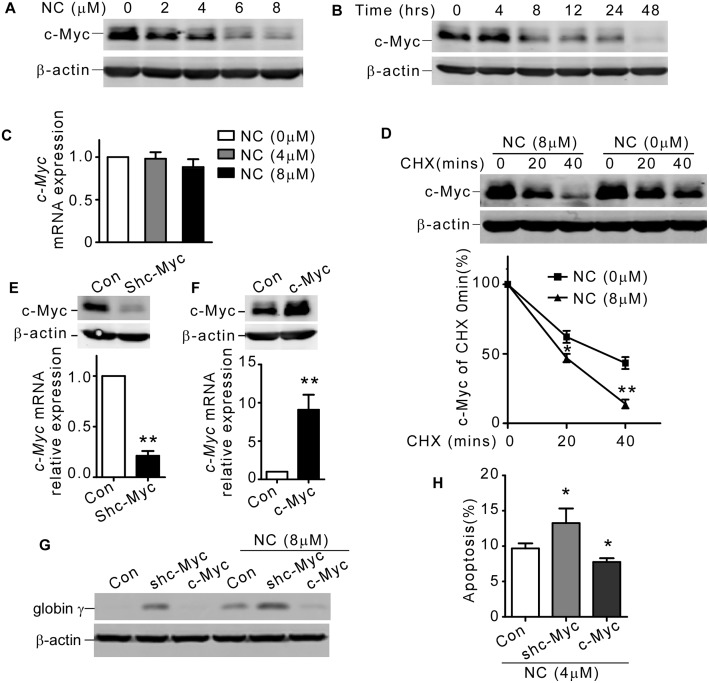
NC downregulated c-Myc protein level by accelerating degradation in K562 cells.(A and B) K562 cells were treated with 0, 2, 4, 6 or 8 μM NC for 2 days, or 8 μM NC for 0, 4, 8, 12, 24 and 48 hrs. Western blot analysis was performed to examine the expression level of c-Myc, and β-actin was used as internal control. (C) Real time qRT-PCR showed the c-Myc mRNA levels in K562 cells treated with indicated concentrations of NC for 2 days. β-actin was used as internal control. The values represent the means ± S.E. (n = 3). (D) K562 cells were exposed to 8 μM NC for 2 hrs, and then chased with 150 μg/mL CHX for 0, 20 and 40 mins. c-Myc and β-actin were detected by western blot. The values represent the means ± S.E. (n = 3). *, P < 0.05. **, P<0.01. (E) K562 cells were stably transfected with shc-Myc or control shRNA. (F) K562 cells were stably transfected with pIRES-c-Myc or control plasmid. c-Myc protein (upper panel) and mRNA (lower panel) level was detected by western blot and real-time qRT-PCR, respectively. The values represent the means ± S.E. (n = 3). **, P<0.01. (G) K562 cells stably transfected with shc-Myc, pIRES-c-Myc or control plasmid, were exposed to NC for 2 days. globin γ and β-actin were detected by western blot. (H) K562 cells stably transfected with shc-Myc, pIRES-c-Myc or control plasmid, were exposed to NC for 2 days. Apoptosis rate was detected by annexin V/PI double staining. The values represent the means ± S.E. (n = 3). *, P < 0.05.